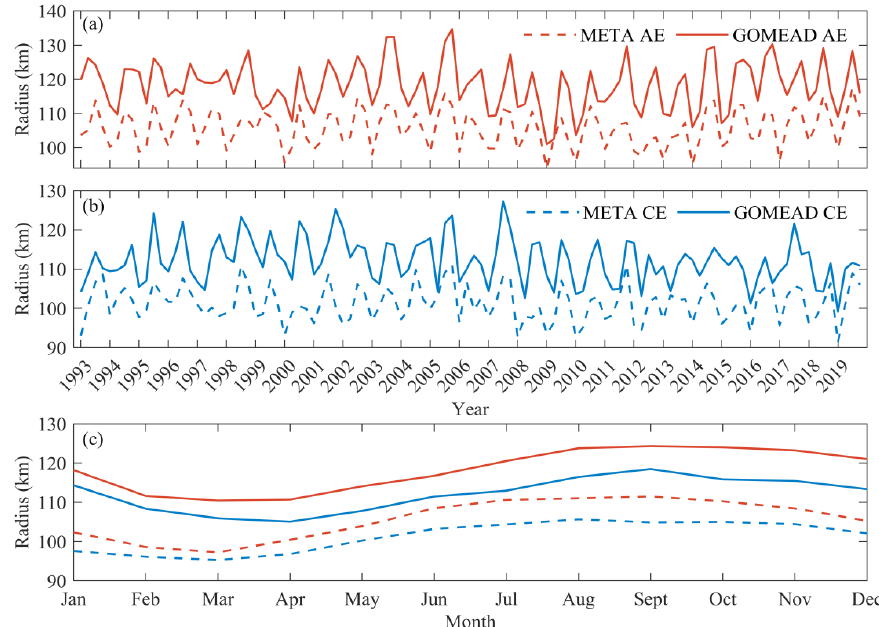
Figure 8. Variation of the eddy radius in the SF region. Eddy radius annual time series of ( a ) AE and ( b ) CE, and ( c ) the monthly variation of four regions. The time resolution of annual time series is 3 months.